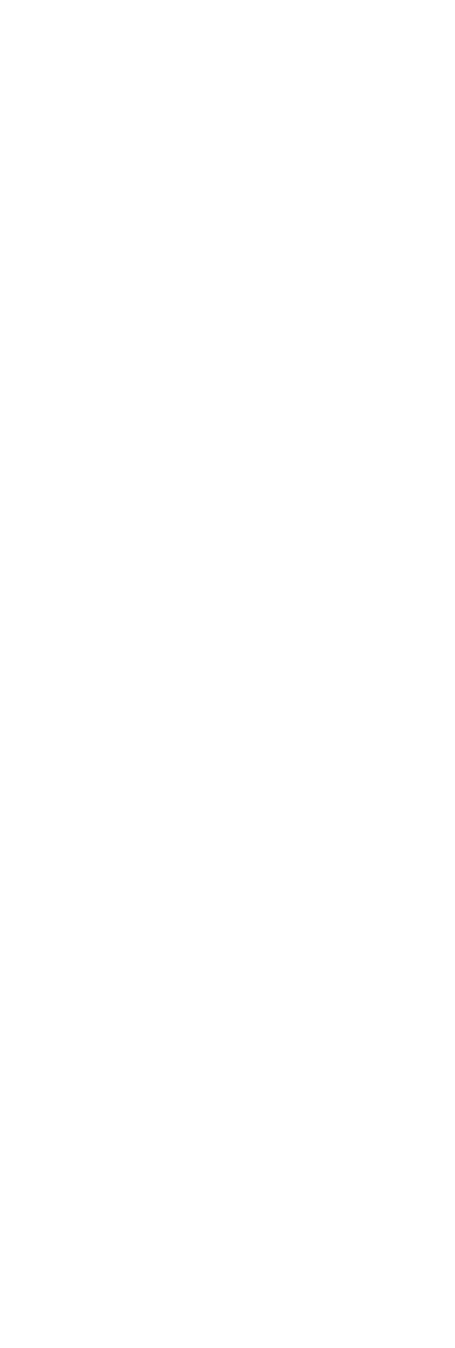
Figure 9. Quantification of selected oxylipins in the blood plasma of Alox15b -KI mice and out- bred wildtype controls. Male Alox15b -KI mice and outbred wildtype controls ( n = 5 for each geno- type) were sacrificed, EDTA blood was removed, plasma lipids were extracted and the free plasma oxylipidomes were quantified with LC-MS (for methodological details see Section 2). Quantifications of selected metabolites are given. ( A ) Sum of all quantified oxylipins (OH-PUFAs). ( B ) Quantifica- tion of the most relevant arachidonic acid (AA) metabolites, ( C ) Quantification of the most rele- vant 5,8,11,14,17-eicosapentaenoic acid (EPA) metabolites. ( D ) Quantification of the most relevant 4,7,10,13,16,19-docosahexaenoic acid (DHA) metabolites. ( E ) Quantification of the most relevant 8,11,14- eicostrienoic acid metabolites. * indicates significant difference at p < 0.05, ** indicates significant differences at p < 0.01. ns, no significant